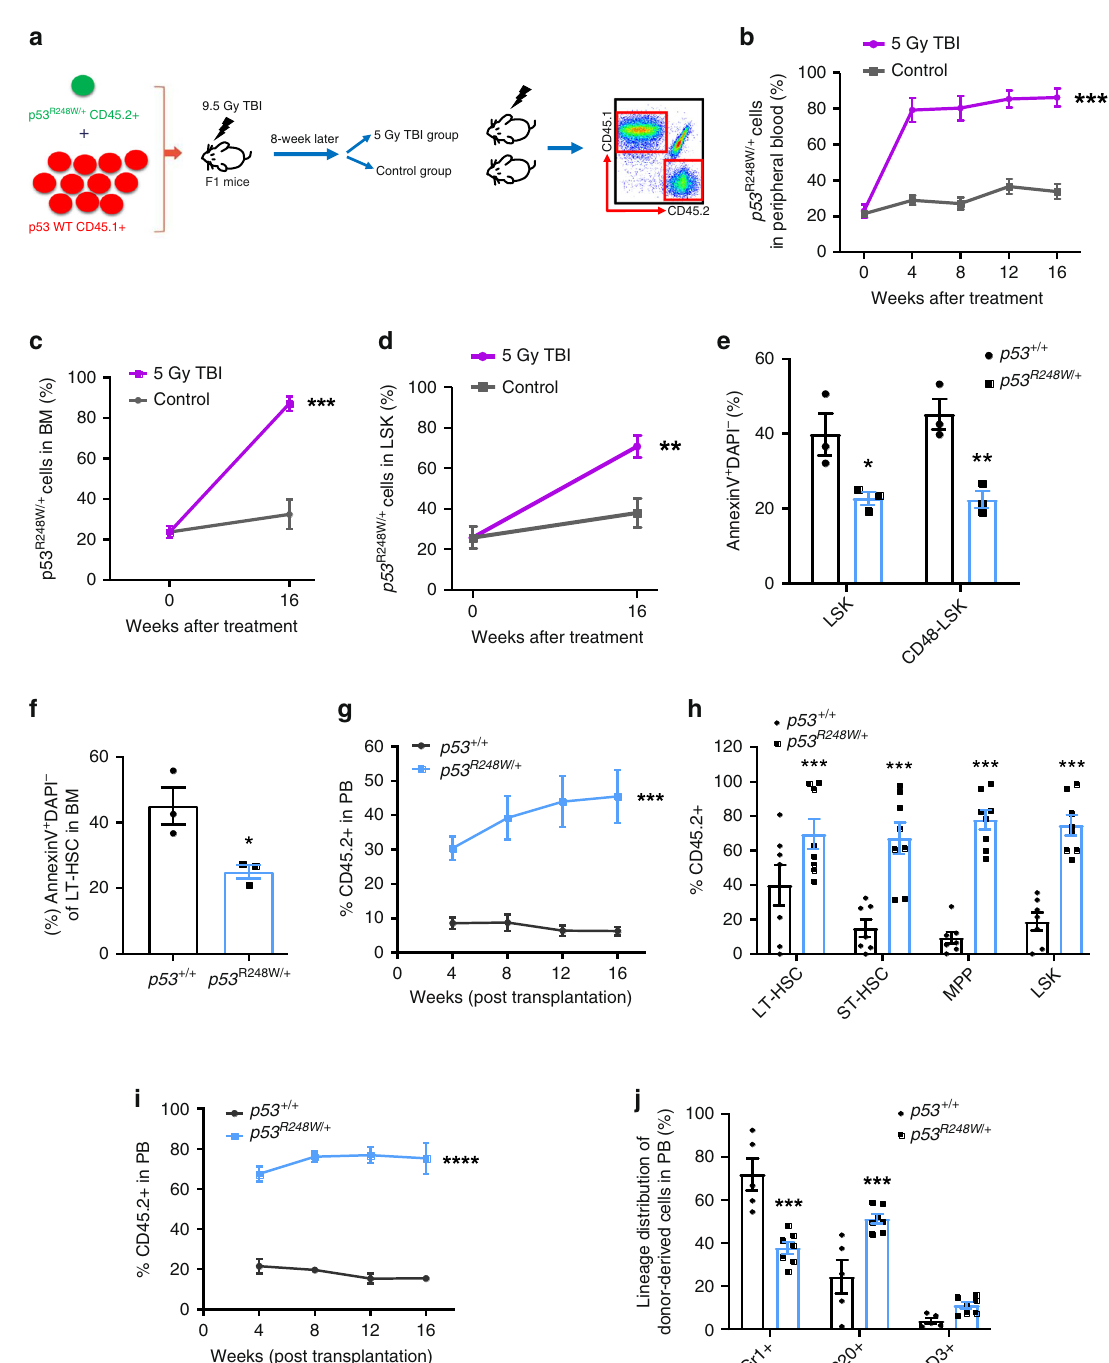
not signi fi cantly change EZH2 target gene signature (Supple- H3K27me3 in p53 mutant HSPCs compared to WT HSPCs (Fig. 4c). Further, p53 R248W/ + HSCs displayed higher levels of H3K27me3 compared to p53 + / + HSCs quanti fi ed by fl ow cytometry analysis (Fig.